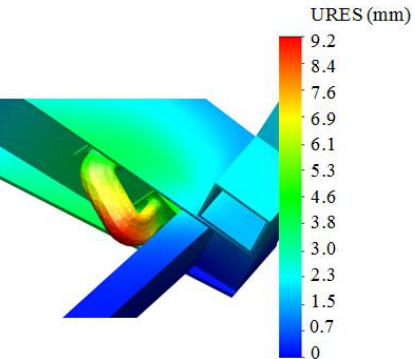
Figure 25. Displacements in the node to secure the hopper wagon on the deck.